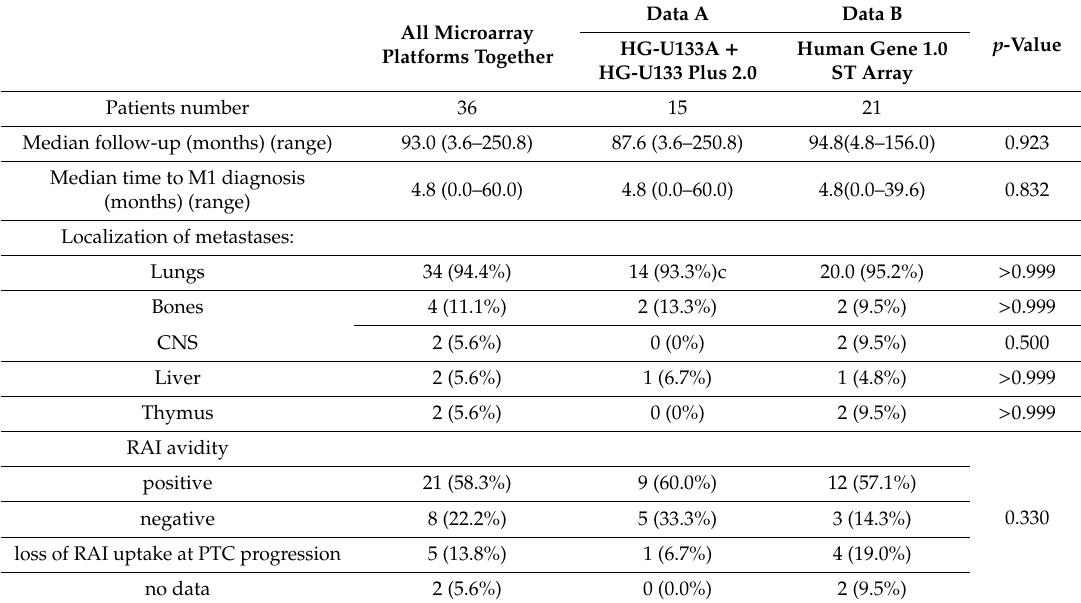
Table 7. Characteristics of M1 PTC patients analyzed by